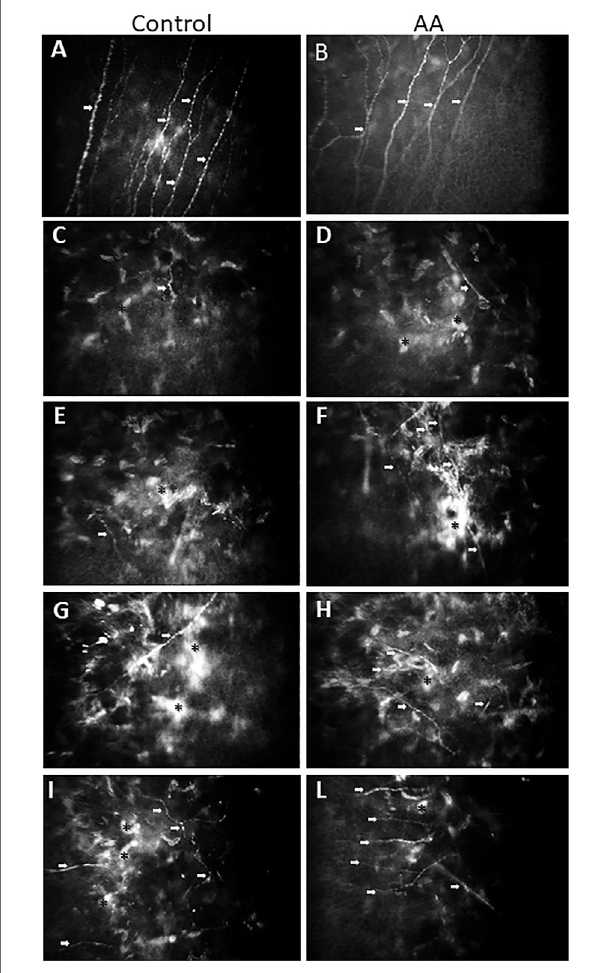
FIGURE 3 | Representative confocal images taken where the SBNP fi bers best appear on focus. (A) : image taken from a control patient before PRK; (B) : image taken from an AA-treated patient before PRK. Both pictures show the normal path of SBNP fi bers, which appear with a regular, almost parallel pattern. Representative confocal images of SBNP nerve fi bers were taken at different times after PRK of the control patient (left column: treated for − 3.50 D of SE with ablation of 67 microns) and of the AA-treated patient (right column: treated for − 4.50 D of SE with ablation of 70 microns). After 1 month from PRK there is an initial presence of nerve fi bers (among activated, hyper-re fl ective stromal cells) in the AA group (D) , while in the control group (C) no nerves or sporadic fi bers could be detected. After 3 monthsfromPRKanincreasednumberofSBNP fi bersisapparentintheAA group (F) , while in the control group (E) some nerve fi bers start to be detectable. After 6 months from PRK all examined eyes exhibit SBNP fi bers, but the density is signi fi cantly higher in the AA group (H) than in control eyes (G) . After 12 months from PRK the nerve fi ber density is higher in the AA group, also showing a more regular linear pattern (L) than in control eyes of patientsnottreatedwithAA (I) .Whitearrowsindicategrowing fi bers;asterisks indicate activated, hyper-re fl ective stromal